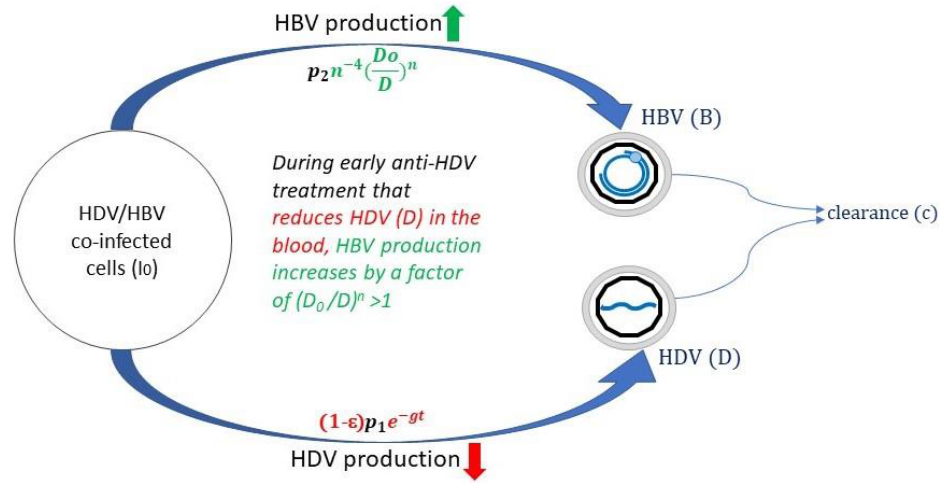
Figure 1. A schematic diagram of our new model. The figure relates to the phase where HDV declines and HBV increases. The model comprises only two equations: